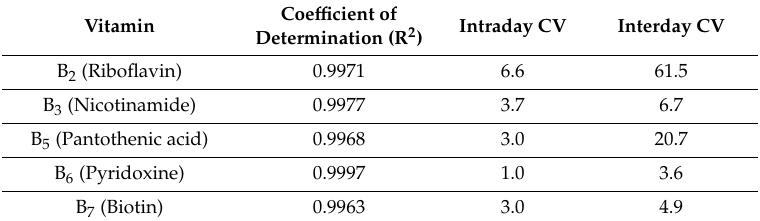
Table 2. Validity of the method in terms of standard curve linearity and precision.